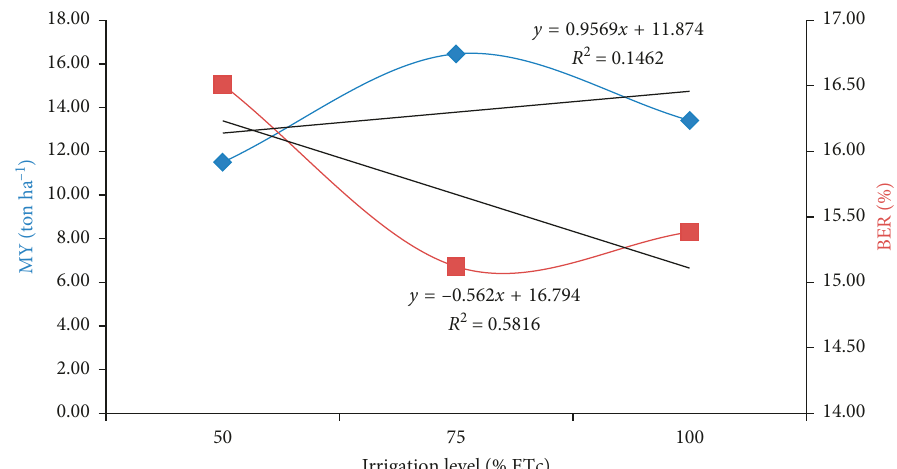
Figure 1: Relationship of irrigation water levels (% ETc) with marketable yield (MY) and BER incidence.